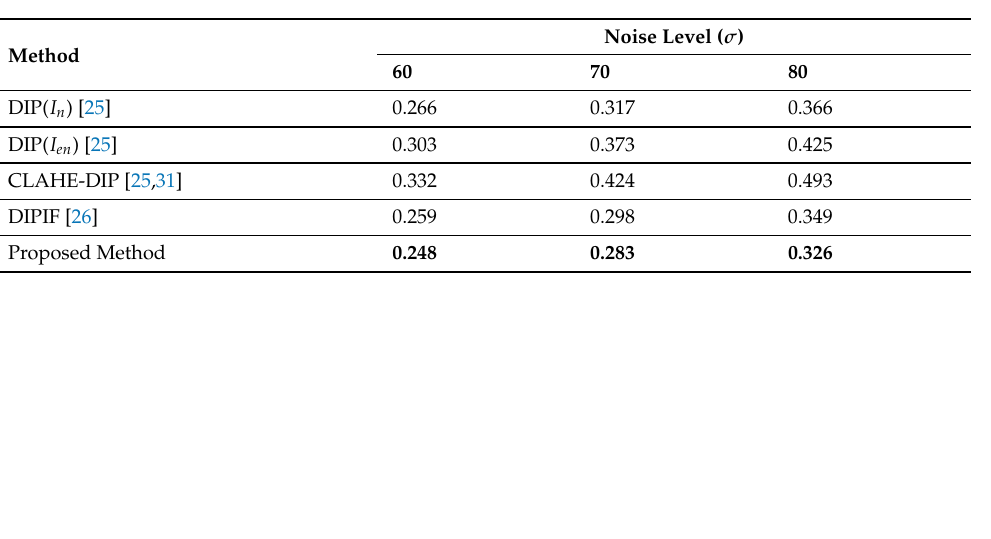
Table 2. The average LPIPS values of our proposed method and the competitive denoising methods on 10 randomly selected test images. Note that a smaller value of LPIPS implies a better result in